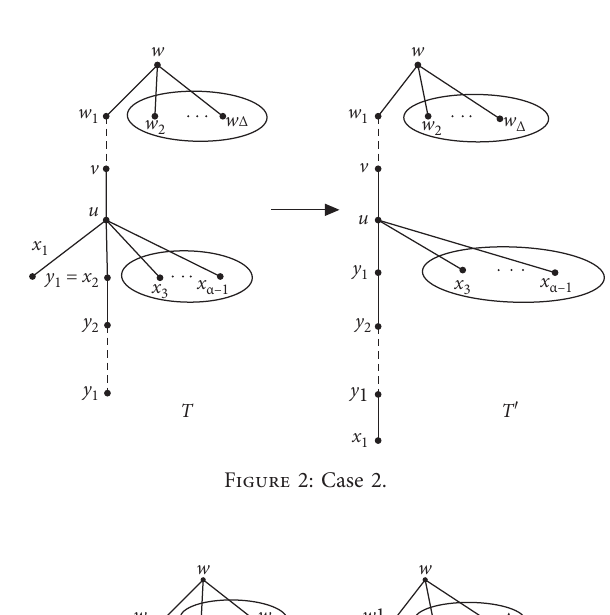
Figure 1: Case 1.